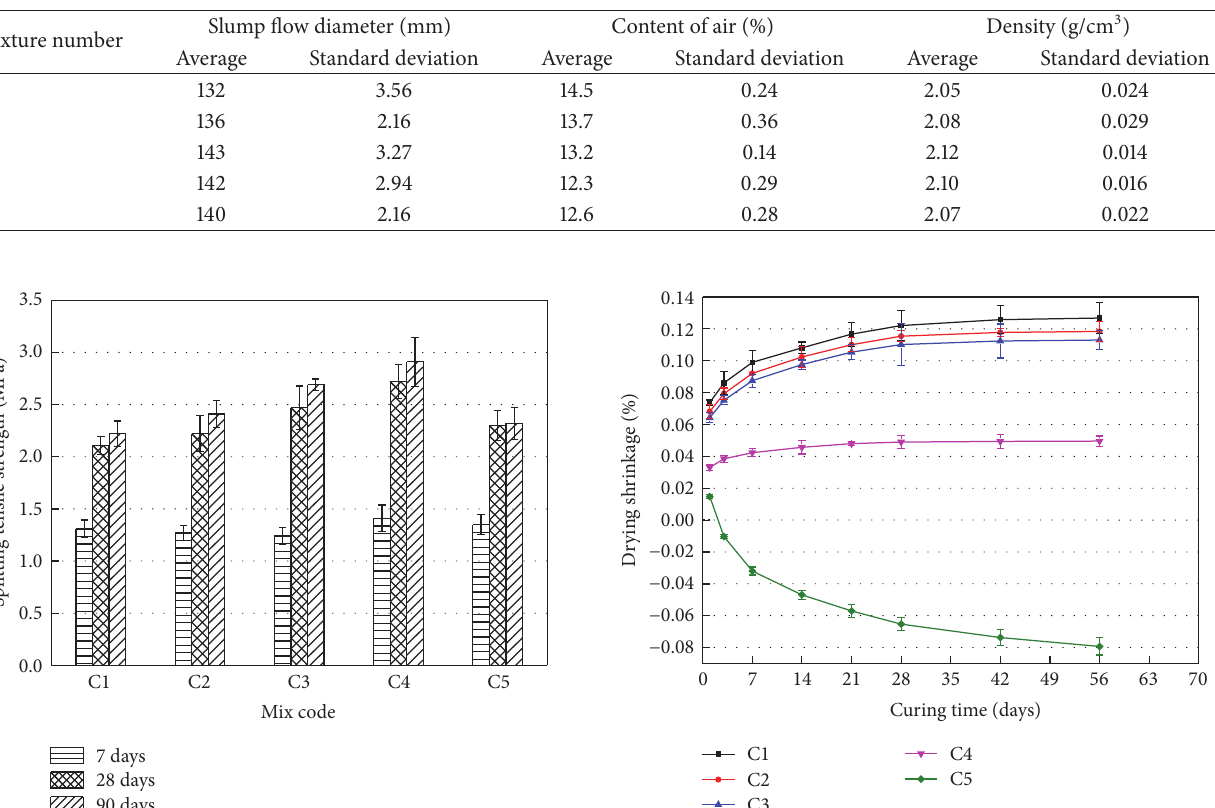
Table 3: Fresh properties of cementitious materials.